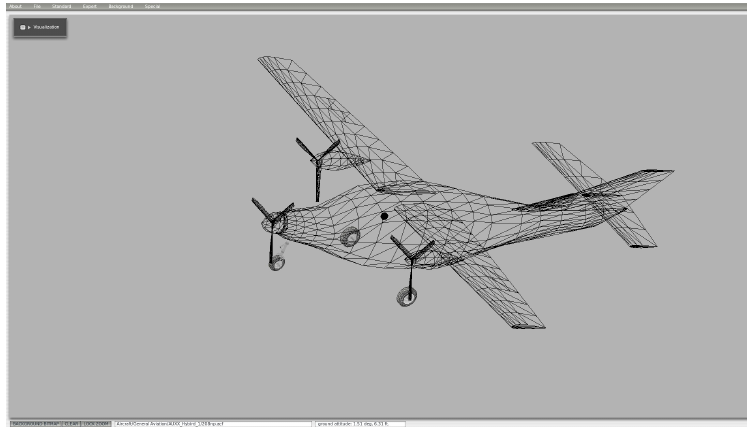
Figure 14. X-Plane “Plane-Maker” AUXX hybrid model.